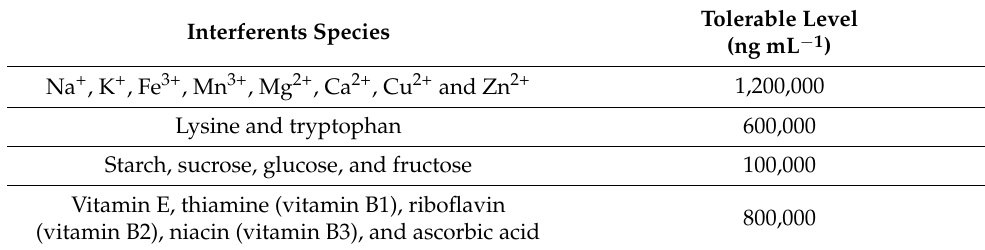
Table 1. Tolerable levels of possible interfering species in the determination of phenolic compounds (ferulic acid, sinapic acid, p -coumaric acid) of maize kernels. Interferents Species